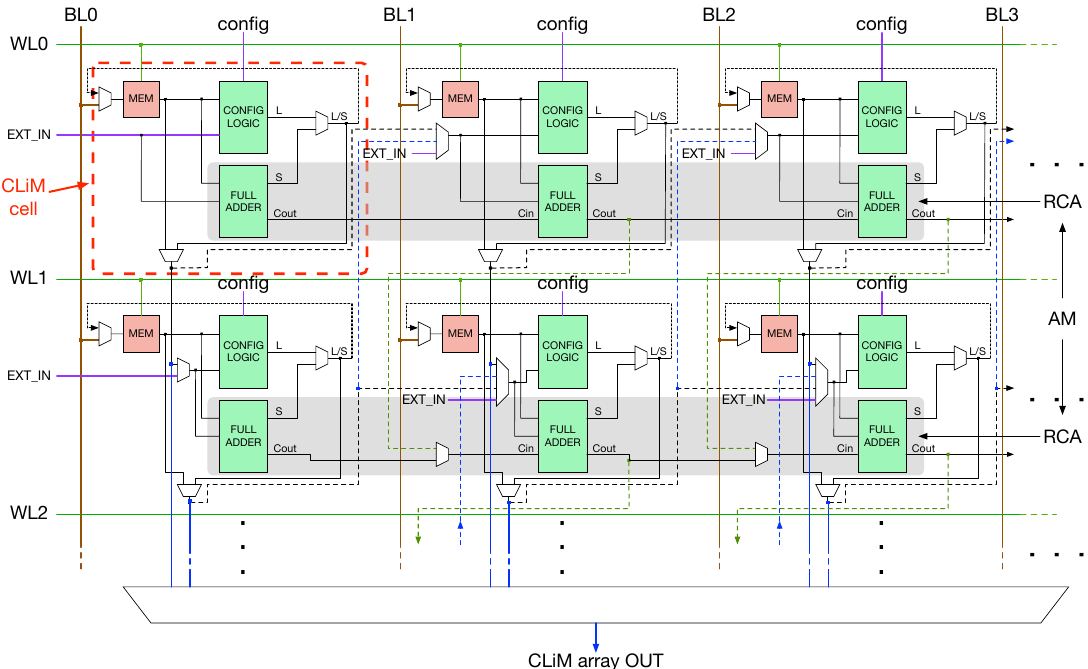
Figure 3. Detailed internal structure of the Configurable Logic-in-Memory (CLiM) array. Each CLiM cell can be represented as a logic-enhanced memory cell where data can be computed locally. By exploiting inter-cells connections it is possible to build more complex in-memory functions (e.g., a Ripple Carry Adder (RCA) or and Array Multiplier (AM)).